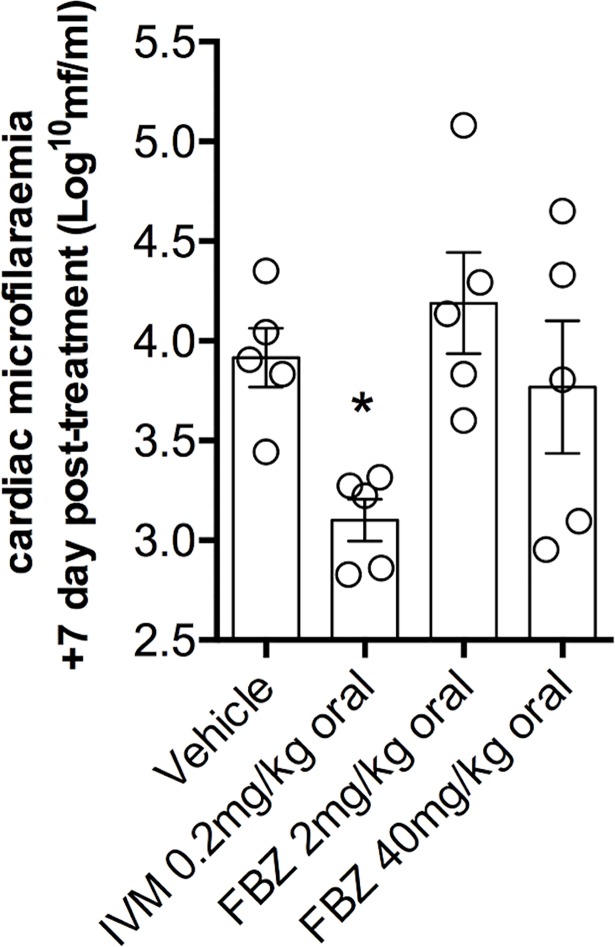
Average B. malayi microfilariaemias in cardiac blood seven days post-dosing with indicated treatments.Data points are microfilariaemias per mouse. Bars are mean +/-SEM per treatment group. Variation between untreated and treatment groups was significantly different (1way ANOVA F = 4.6, P = 0.019). Significant differences compared with vehicle controls, evaluated by Dunnett’s tests, are indicated * (P<0.05).